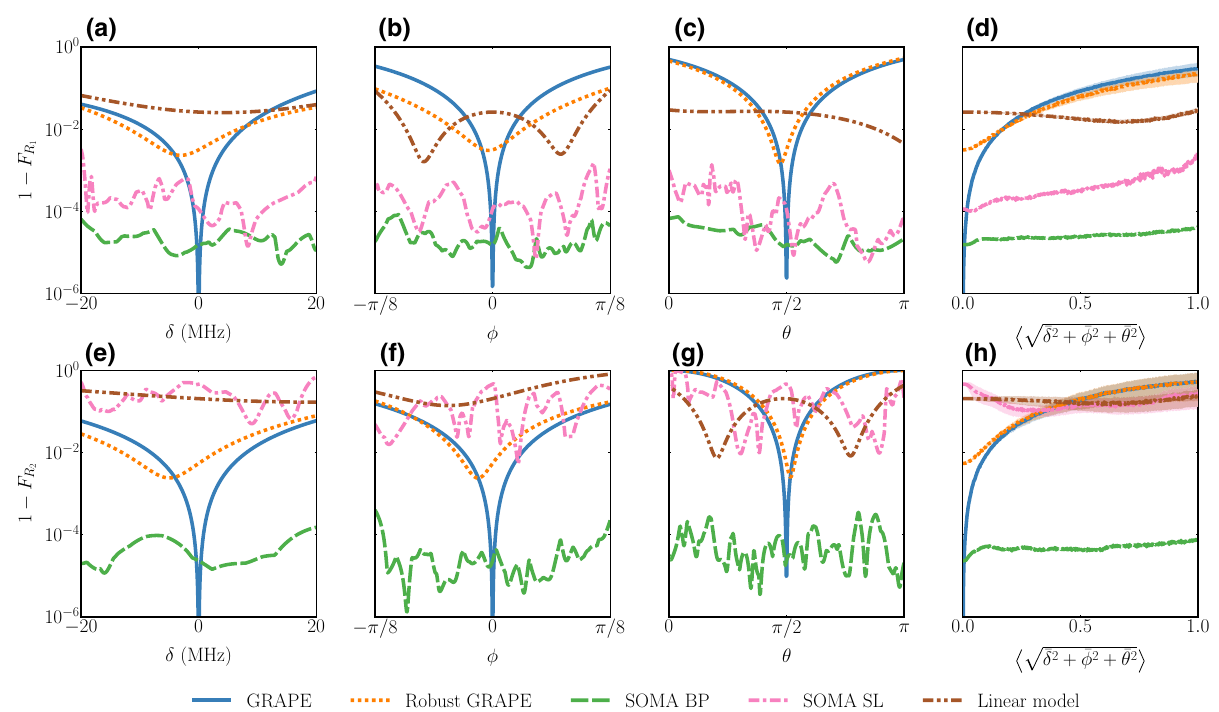
FIG. 5. The infidelity of pulses predicted by the different optimization methods for the R 1 (θ) gate (first row) and the R 2 (θ) gate (second row) as a function of three different quantum control problem parameters: (a),(e) the detuning δ between the qubit frequency and the driving frequency; (b),(f) the phase error φ between the σ + and σ − terms; and (c),(g) the angle θ parametrizing the target gate. (d),(h) The average performance (1000 test samples) of the algorithms as a function of the radial distance from the center (cid:4) λ 0 of the parameter space. The terms ¯ δ , ¯ φ , and ¯ θ indicate that the problem parameters are renormalized to the space [0, 1] D (see Appendix B). The shaded regions around each plot line show the standard deviation of the corresponding infidelities. A more detailed discussion about the standard deviation can be found in Appendix B. Both gates are optimized with four Fourier components for each one of the two control fields for T = 10 ns using the Hamiltonian in Eq.